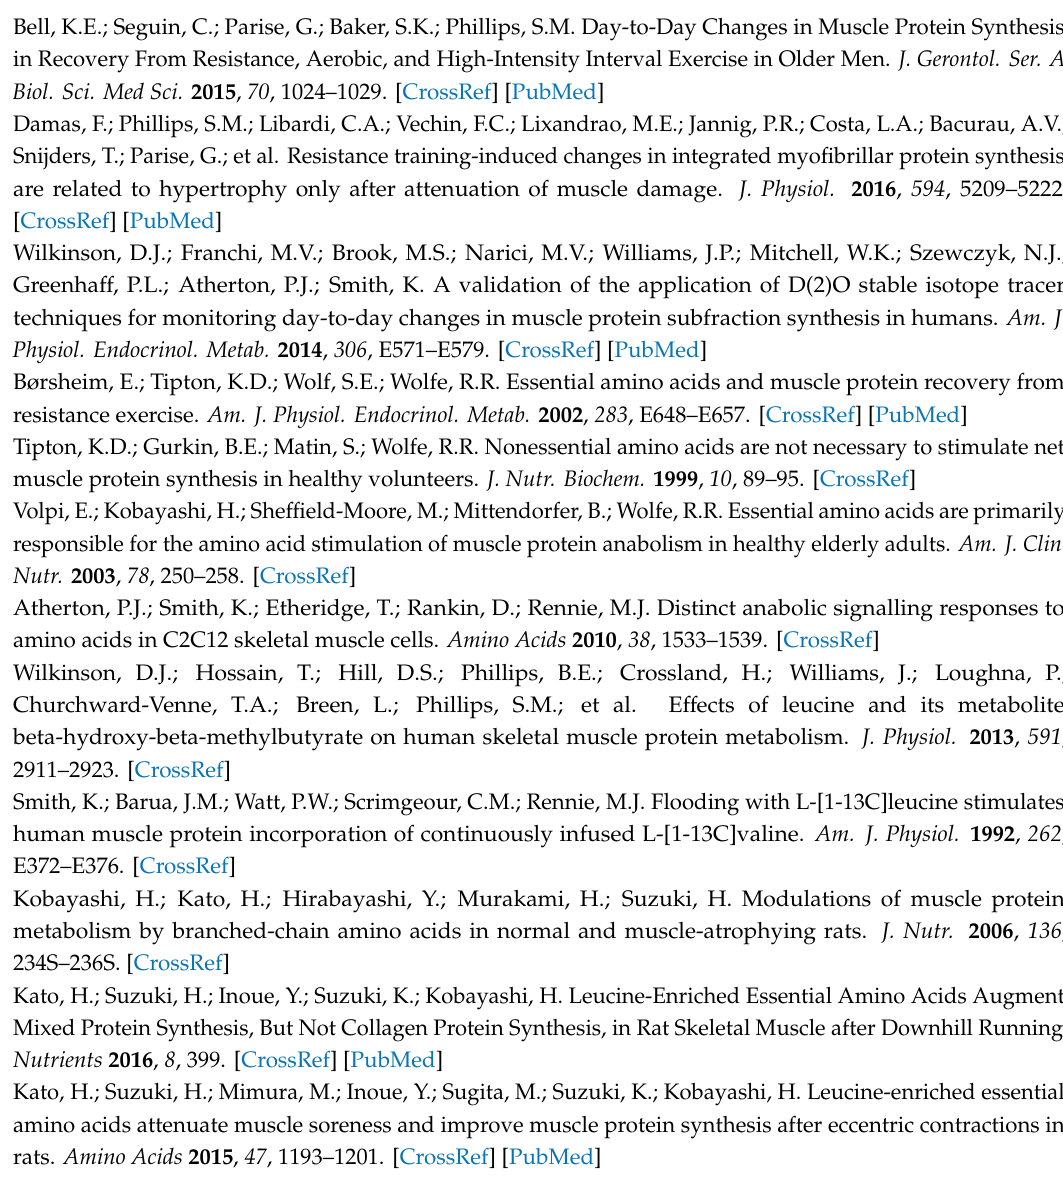
Figure S1: Linear correlations for select post-resistance exercise